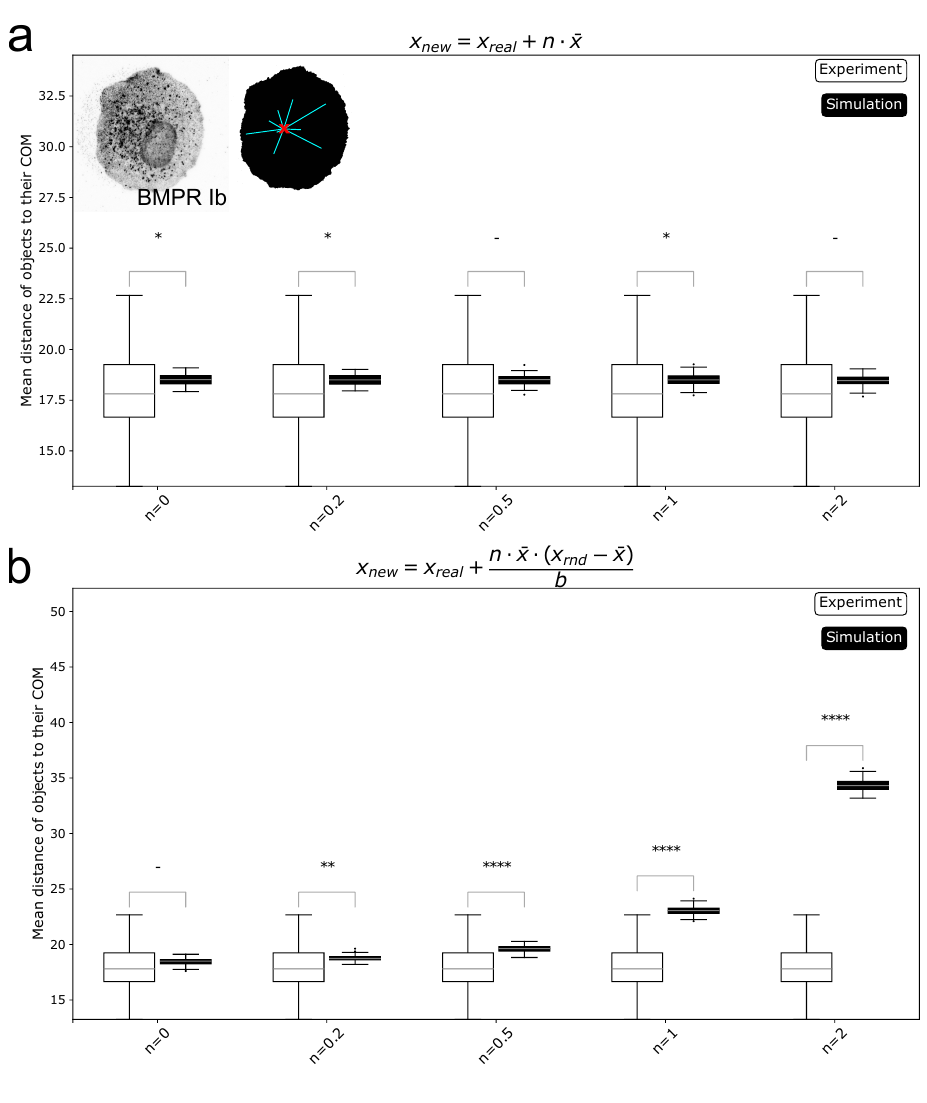
Figure 4. Comparison of simulated and experimental data for spread metric. ( a ): Simulations of a shift in distributions ( x new = x real + n · ¯ x ). ( b ): Simulations of a spread in distributions ( x new = n · ¯ x · ( x rnd − ¯ x ) x real + ). Here, for all values of n > 0 significant differences were found. Spread b metric is sensitive to the spreading of distributions. * = p < 0.05, ** = p < 0.01, **** = p < 0.0001, - = not